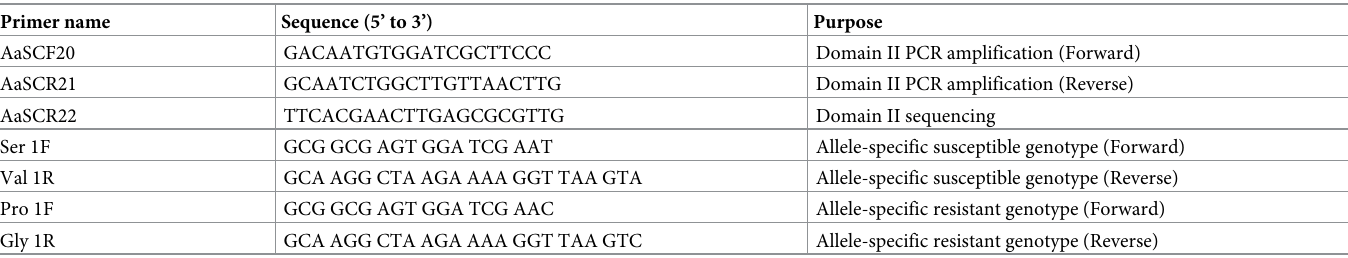
Table 1. Vssc primers used for genotype selection and